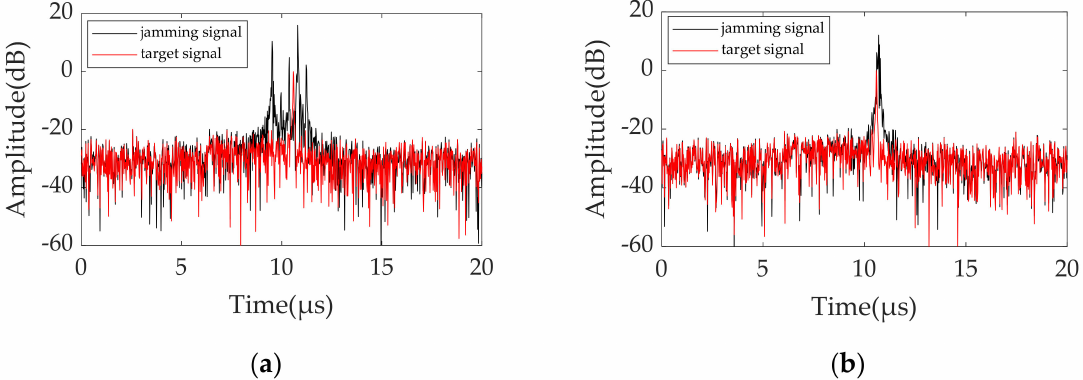
Figure 6. Comparison of imaging results with different jamming delay sequences. ( a ) Jamming delay (cid:8) (cid:9) τ q 1 sequences ; ( b ) jamming delay sequences